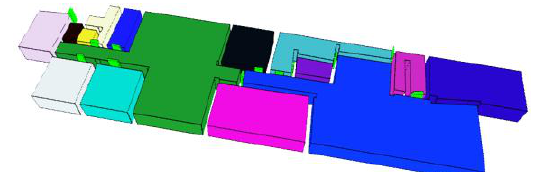
Figure 5: Smooth space reconstruction from Boolean operations.